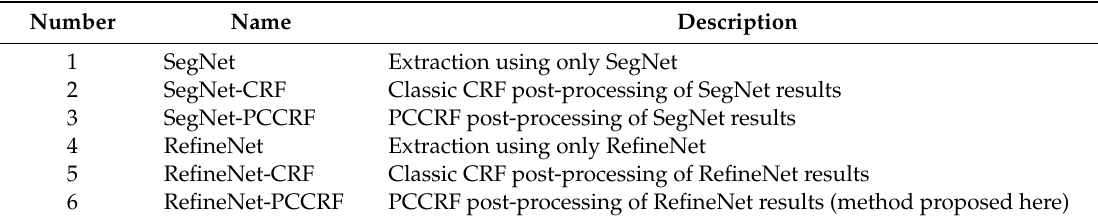
Table 1. Model configurations used for the comparative